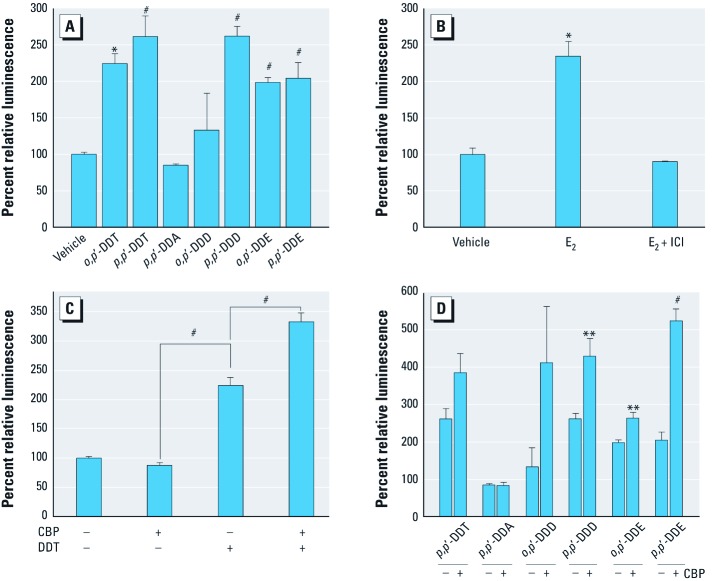
Organochlorines augment CBP activation of transcription from an HRE. (A) MCF‑7 cells transfected with an HRE-luc reporter and incubated with DDT metabolites (10 μM; n = 3). (B) MCF‑7 cells transfected with an HRE as in A, followed by incubation with vehicle, E2, or E2 + ICI (n = 3). (C) MCF‑7 cells transfected with an empty vector or a CBP expression vector plus an HRE-containing luciferase reporter and incubated overnight with vehicle or 10 μM o,p’-DDT (n = 3). (D) MCF‑7 cells treated as in C with metabolites 10 μM DDT (n = 4–6). Luminescence values are shown as the mean ± SE percentage of vehicle control, with the vehicle control set to 100%. *p < 0.05, **p < 0.01, and #p < 0.001, compared with vehicle control (A and B), the metabolite without CBP (D), or as indicated (C).